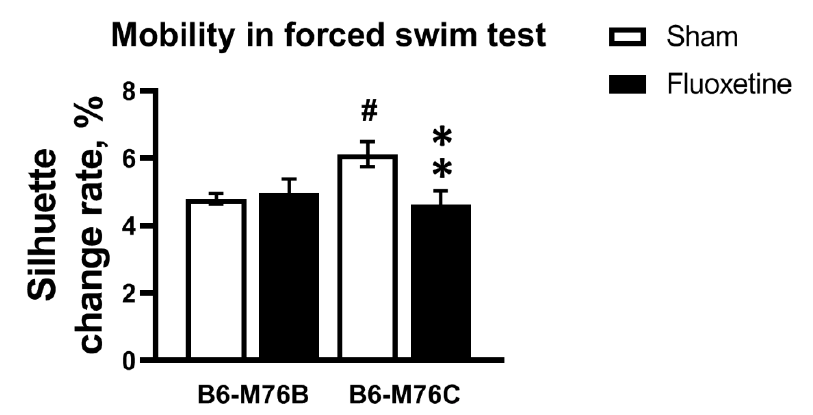
Figure 2. Effect of chronic fluoxetine administration on mobility (estimated as silhouette change rate) in a forced swim test. n ≥ 15 for each group. All values are presented as mean ± SEM. ** p < 0.01 compared to control mice of the same line, # p < 0.05 compared to control B6-M76B mice.